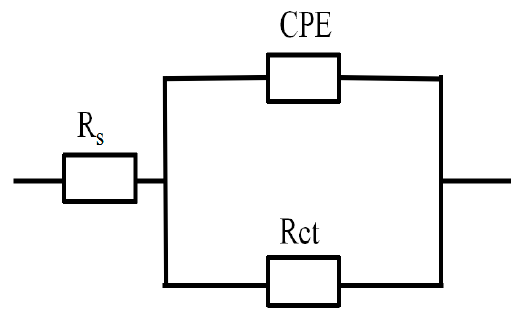
Figure 5. The equivalent circuit model used to fit the electrochemical impedance spectroscopy (EIS) data.